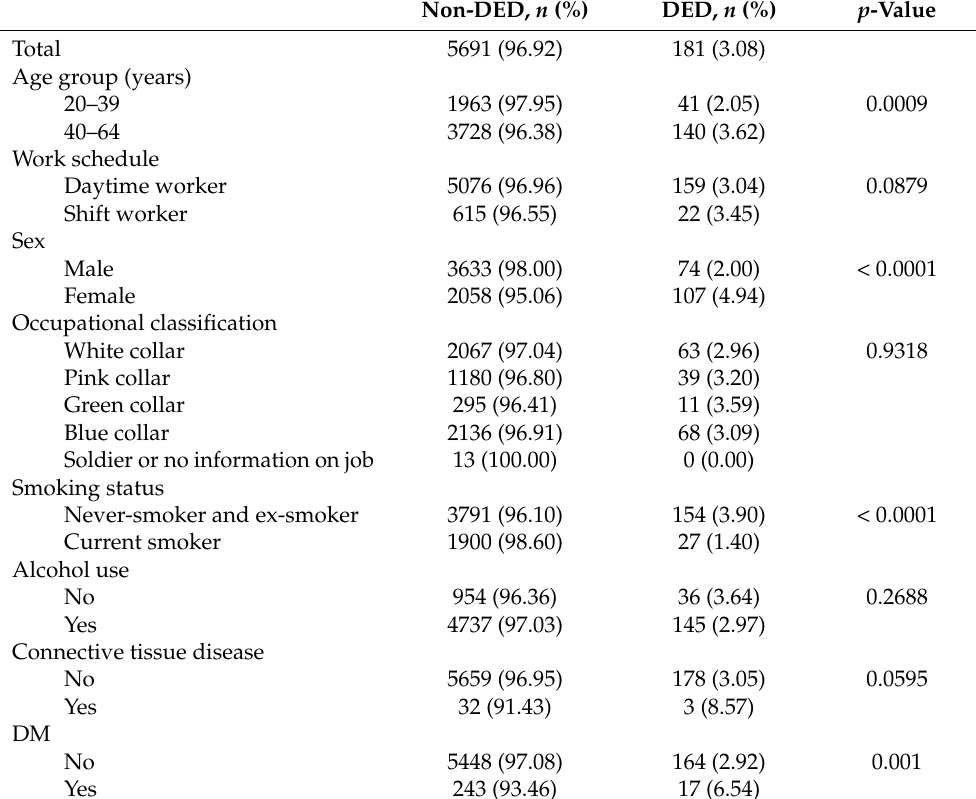
Table 1. Baseline characteristics of workers according to